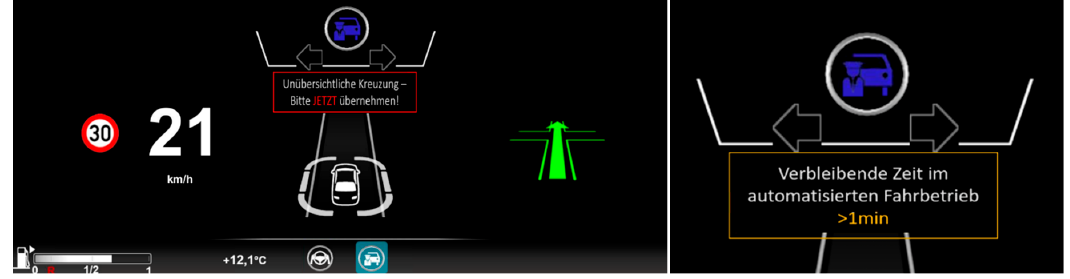
Figure 3. Left: Instrument cluster displaying speed limit, current speed, automation scale, navigation, take-over request, and reason for take-over. Right: predictive HMI textbox, “remaining time in automated mode >1min”.